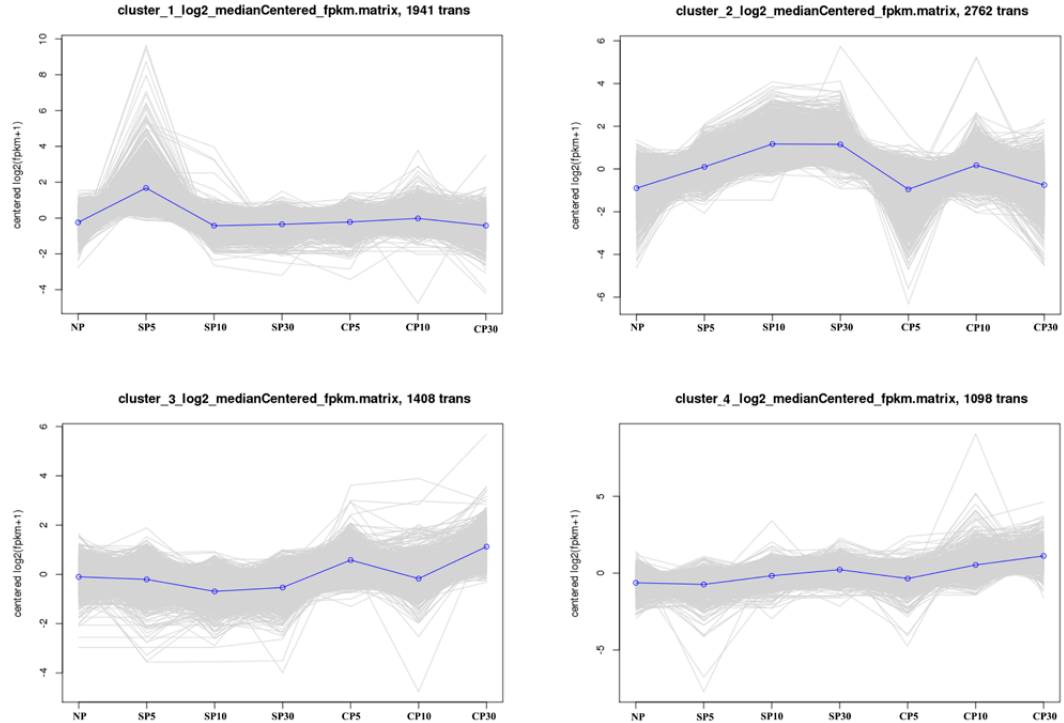
Figure 4. Di ff erent gene expression patterns between self- and cross-pollination as analyzed using K-means clustering. Each square represents a pattern. The horizontal axis represents non-, self-, and cross-pollination at 5 min, 10 min, and 30 min, respectively. NP, nonpollination; SP, self-pollination; and CP,